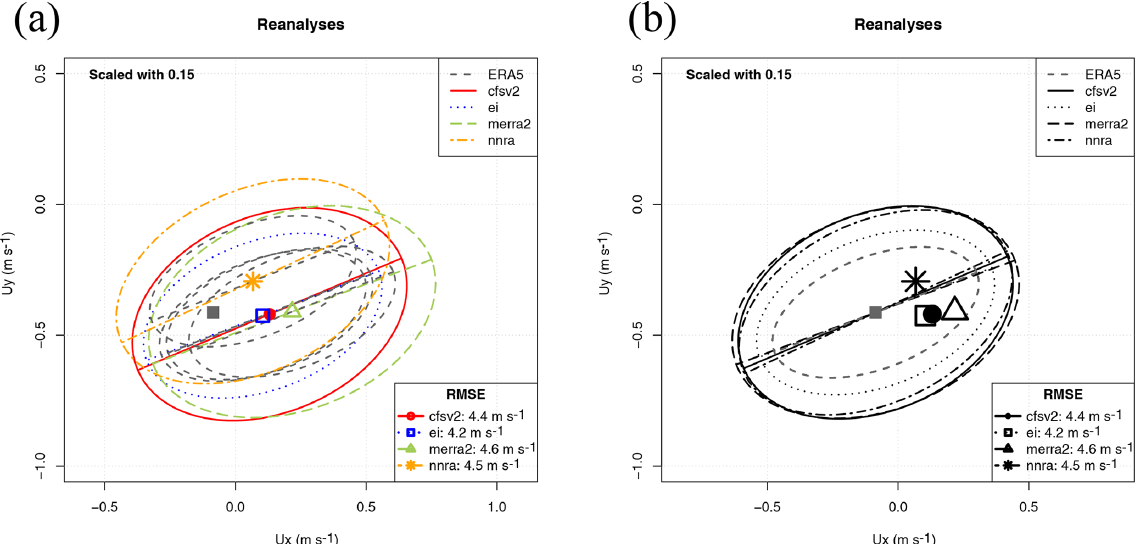
Figure 7. Sailor diagram representing the structure of errors in surface wind in January over the Northern Hemisphere for different reanalyses: uncentred version ( a , scale factor 0.15) and centred version ( b , scale factor 0.15).